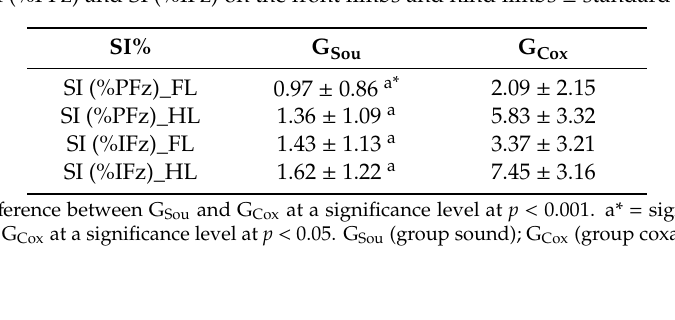
Table 1. SI (%PFz) and SI (%IFz) on the front limbs and hind limbs ± standard deviation.